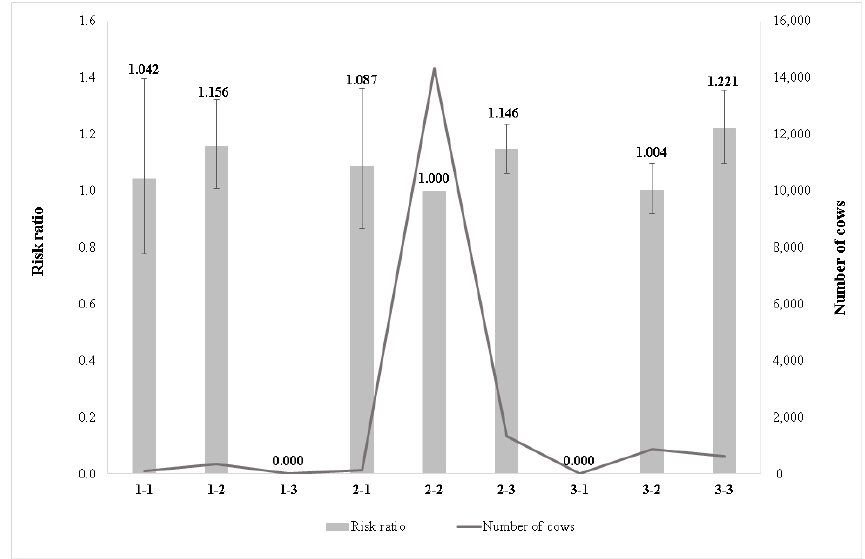
Figure 3. Effect of combination of chest width and body depth on the relative culling risk. 1-1 : narrow chest–shallow body depth; 1-2 : narrow chest–intermediate body depth; 1-3 : narrow chest–deep depth; 3-2 : wide chest–intermediate body depth; 3-3 : wide chest–deep body depth